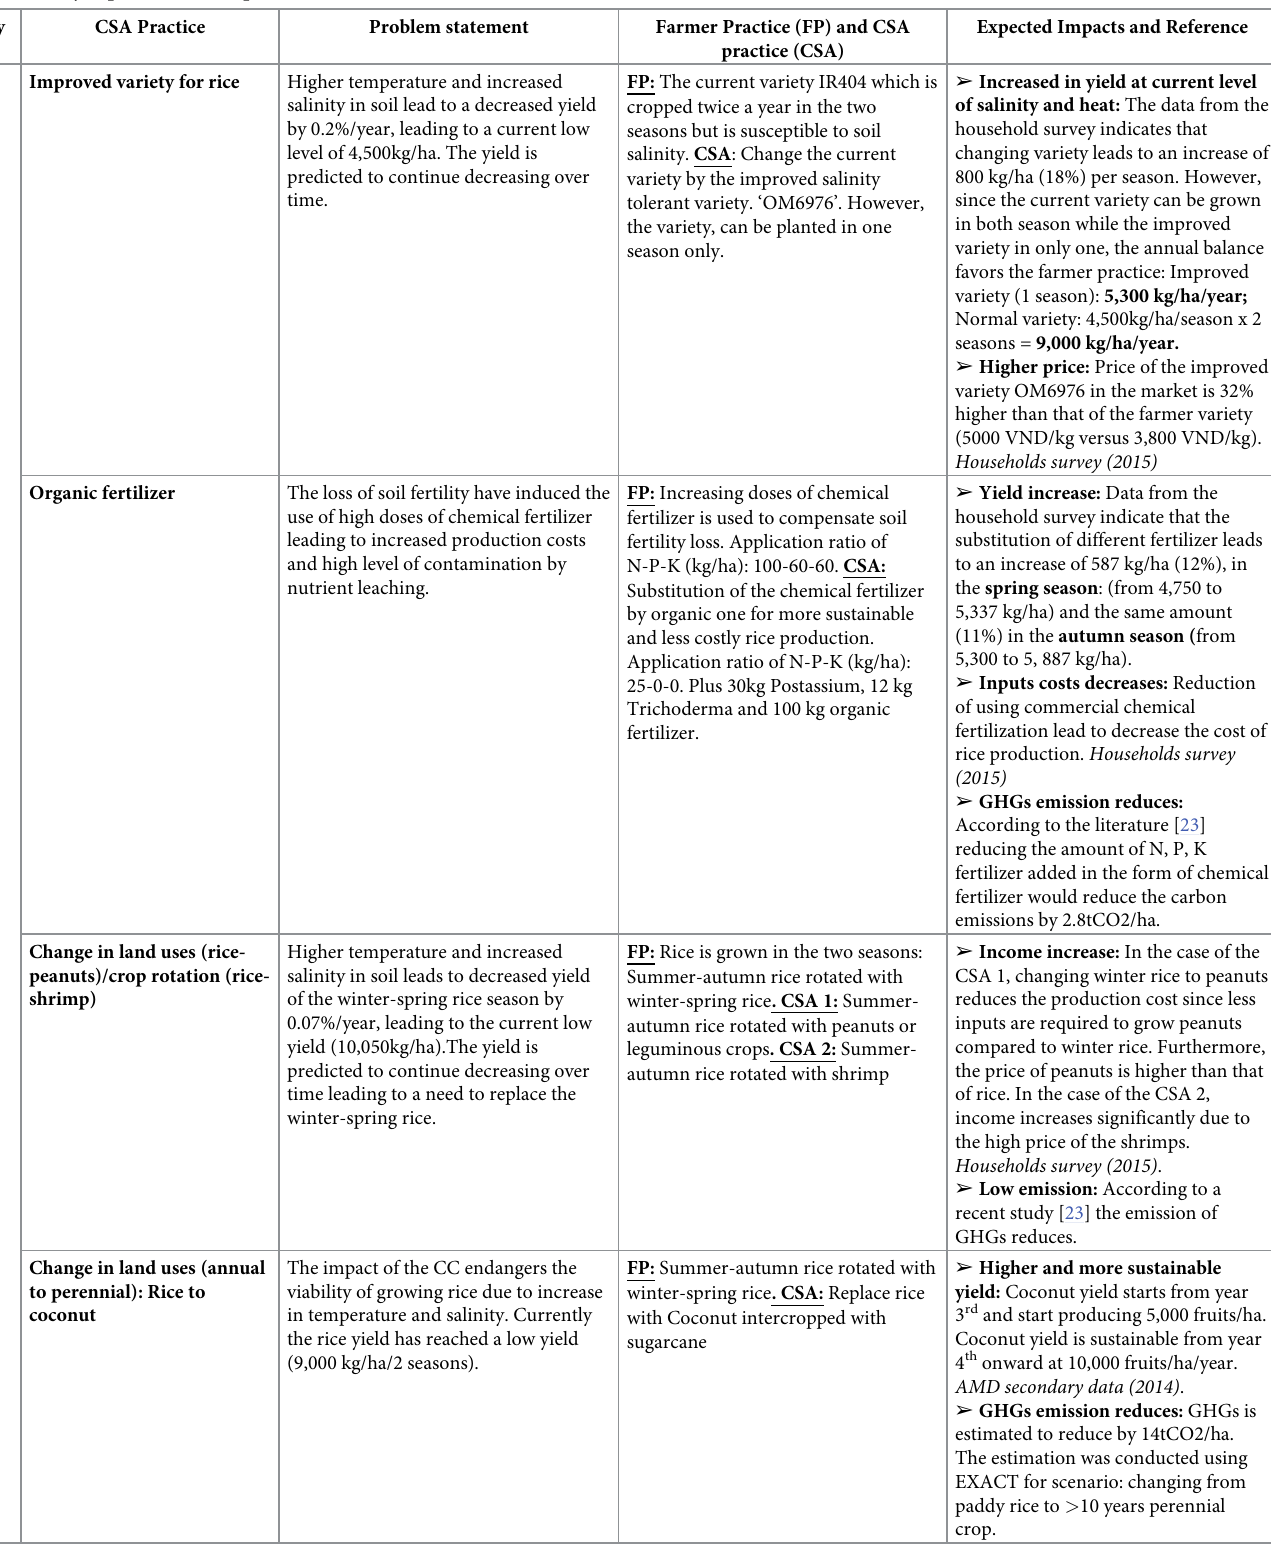
Table 2. Summary of prioritized CSA practices in the three case